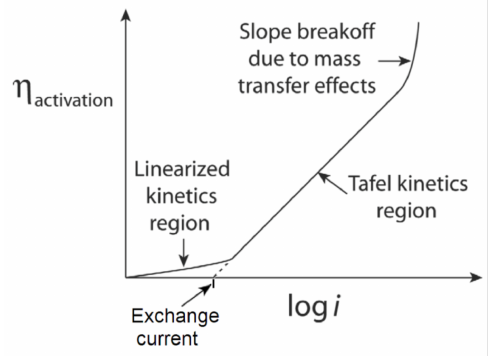
Figure 5. The activation overpotential concerning current is depicted in this